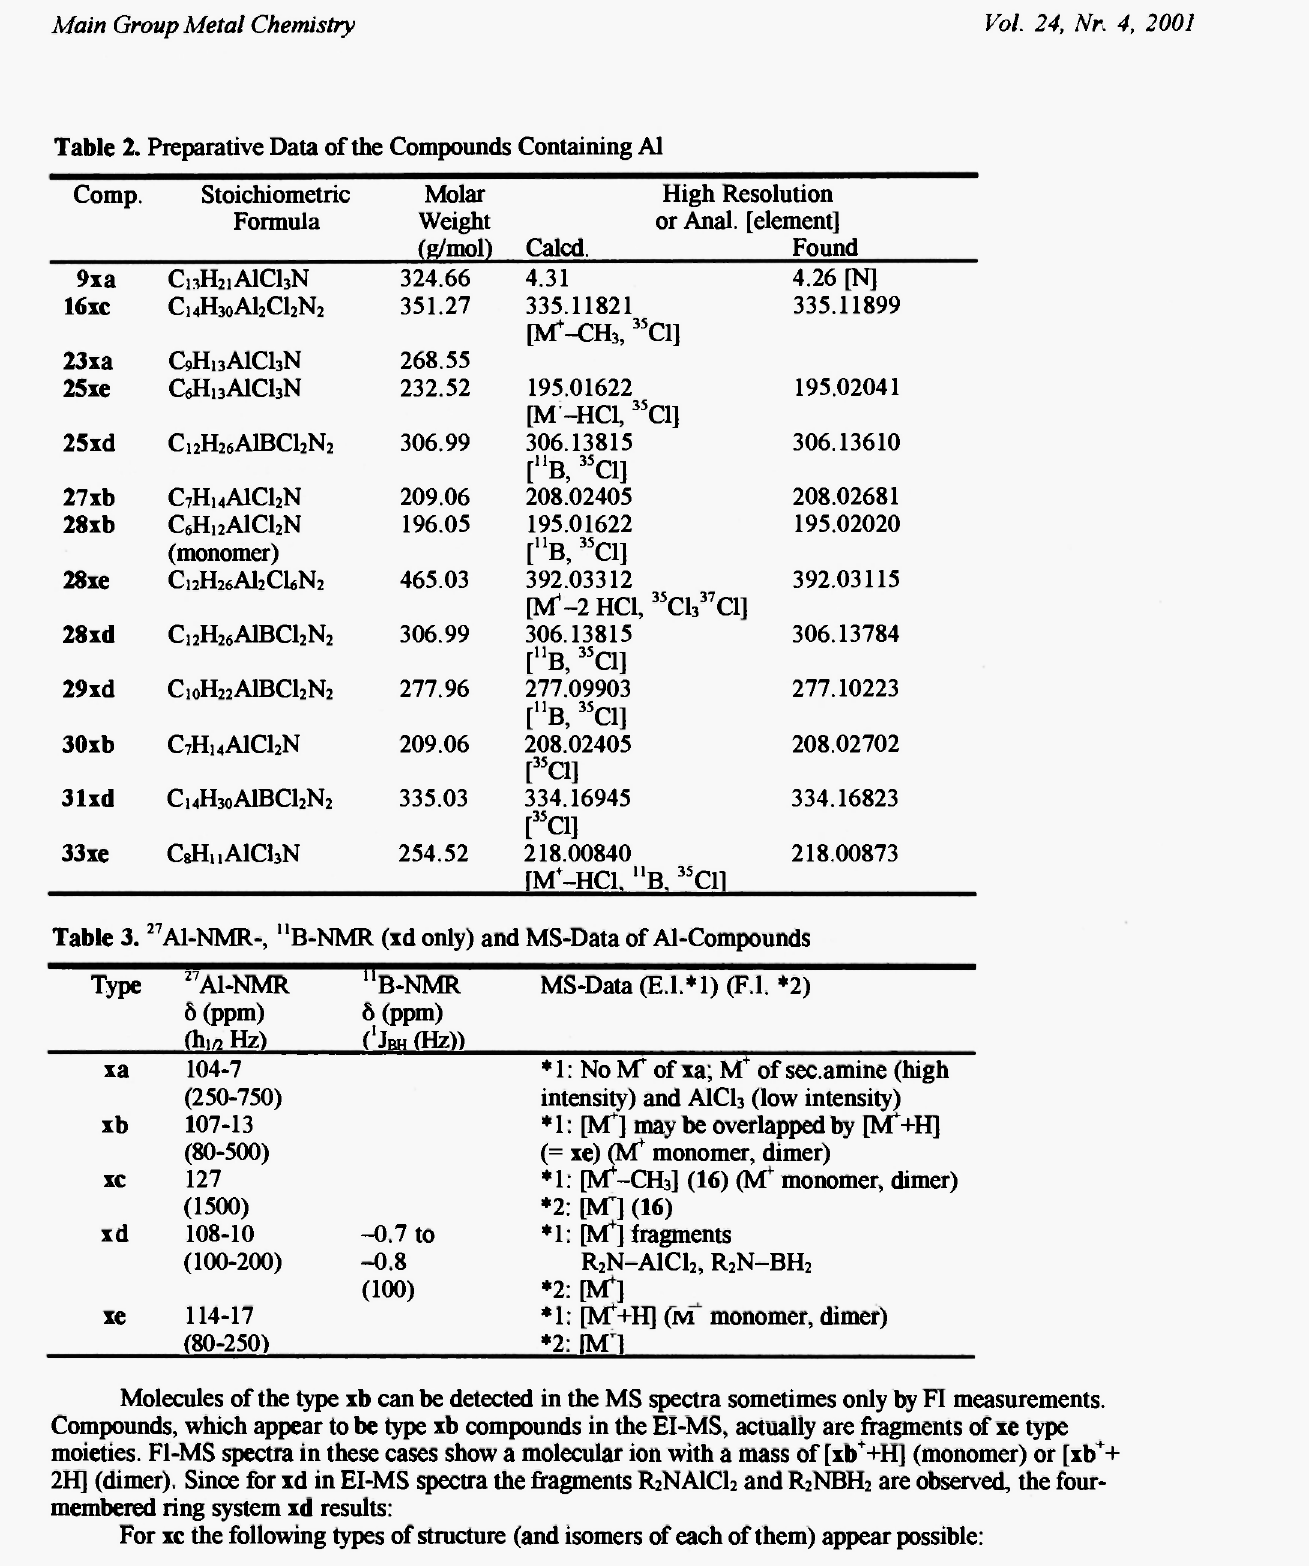
Table 2. Preparative Data of the Compounds Containing Al Comp. Stoichiometric Molar High Resolution Comp. Formula Weight or Anal, [element] Calcd. Found